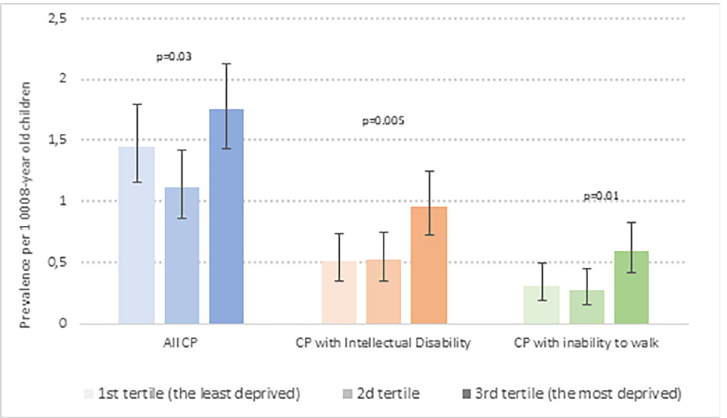
Fig 1. Prevalence and 95% Confidence Interval (CI) of CP (8-year old children born between 2000 and 2011) by three census block groups defined by distribution tertiles of the French European Deprivation Index, weighted on the number of 8-year-old children residing in each block. Prevalences are expressed for 1000 8-year children residing in same areas during the same period. Comparison of prevalence between three groups used negative binomial regression models ( p